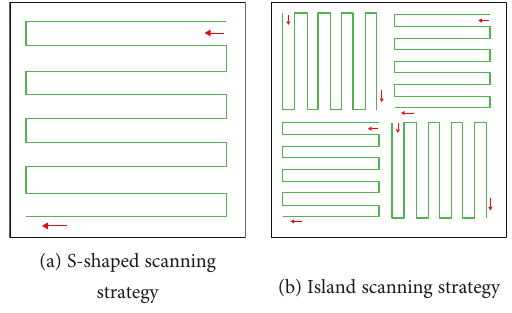
Figure 1: Scanning strategies during the SLM